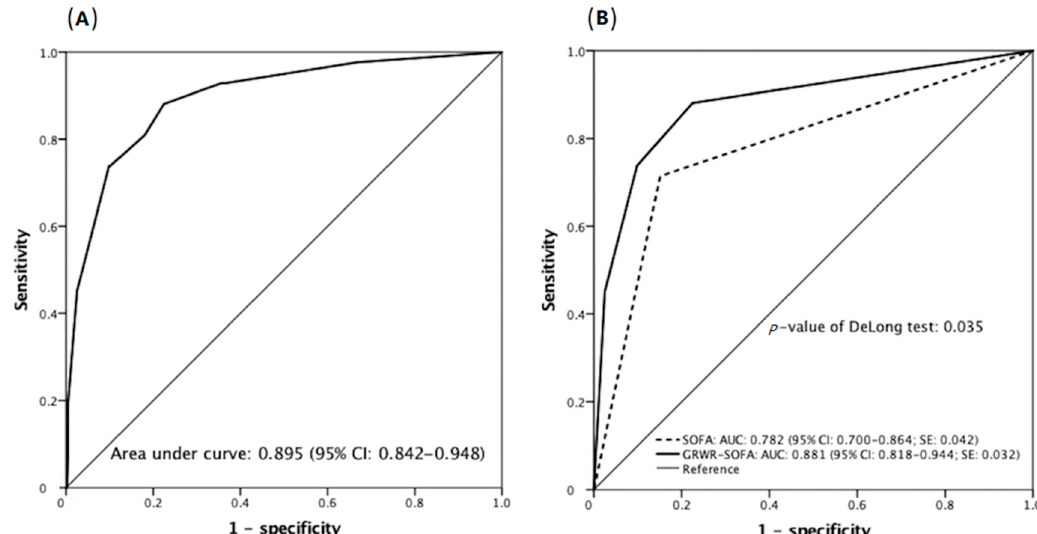
Figure 2. ( A ) Receiver operating characteristic for the graft-to-recipient weight ratio-sequential organ failure assessment (GRWR-SOFA) score affecting 3-month mortality after transplant. ( B ) The newly developed GRWR-SOFA model demon- strates a better discriminative power than the original SOFA model ( p -value of the DeLong test = 0.035).